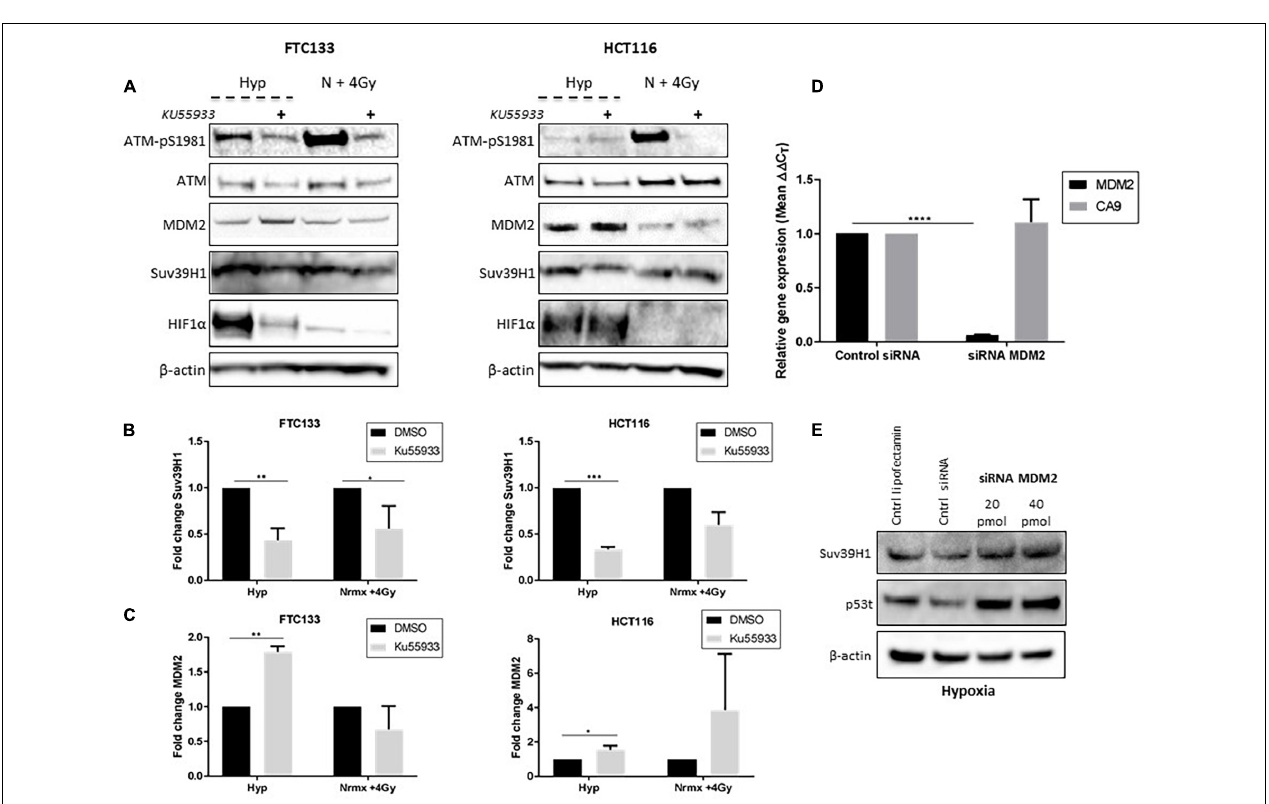
FIGURE 5 | ATM dependent inhibition of MDM2 leads to Suv39H1 upregulation in hypoxia. Cells were incubated in normoxic (N; 21% O 2 ) or hypoxic conditions (H; 0.1% O 2 ) for 18 h. The ATM specific inhibitor (Ku55933) was added 6 h prior to lysis and Western blotting. Treatment with Ku55933 is indicated with the symbol (+). HIF-1 α was used as a control for hypoxia and β -actin as a loading control. Cells irradiated with 4 Gy in normoxia and harvested 45 min later (N + 4 Gy) were used as a positive control for ATM activity (A) . Suv39H1 (B) and MDM2 (C) protein levels were calculated by densitometry and normalized to β -actin and untreated control for each condition. FTC133 cells were transfected with MDM2 siRNA or control siRNA and exposed for 18 h to hypoxia (0.1% O 2 ). Total RNA was extracted and analyzed by RT-PCR. The graph represents the relative gene expression of MDM2 and CA9 compared to the control siRNA (D) . FTC133 cells transfected with 20, 40 pmol of MDM2 siRNA or control siRNA (Cntrl siRNA) were incubated in hypoxia (0.1% O 2 ) for 18 h and the protein levels of Suv39h1 and p53 were analyzed by Western blot (E) . Three independent experiments were performed and the bar represents the mean ± SEM. * p ≤ 0.05, ** p ≤ 0.01, *** p ≤ 0.001, **** p ≤ 0.0001.